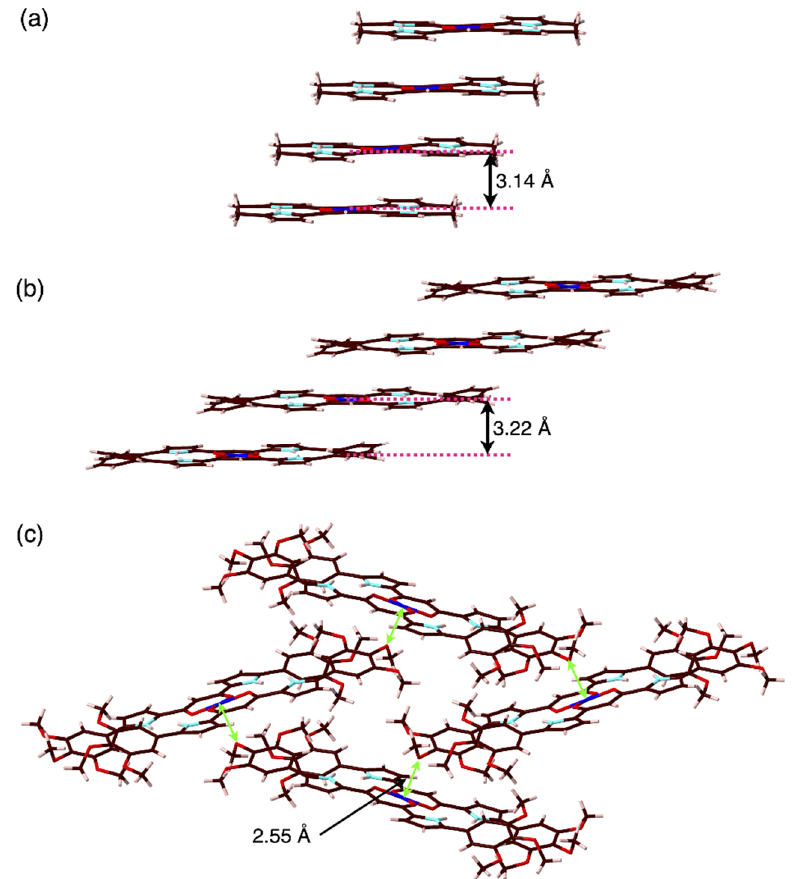
Figure 4. Single-crystal X-ray structures of dipyrrolyldiketone Cu II complexes ( a ) 1a , ( b ) 2a (one of the two independent structures), and ( c ) 2f shown as packing diagrams with, in ( c ), green arrows indicating the coordination between the p -methoxy oxygen and Cu II . Solvent molecules are omitted for clarity. Color code: Brown, pink, cyan, red, and blue refer to carbon, hydrogen, nitrogen, oxygen, and copper,